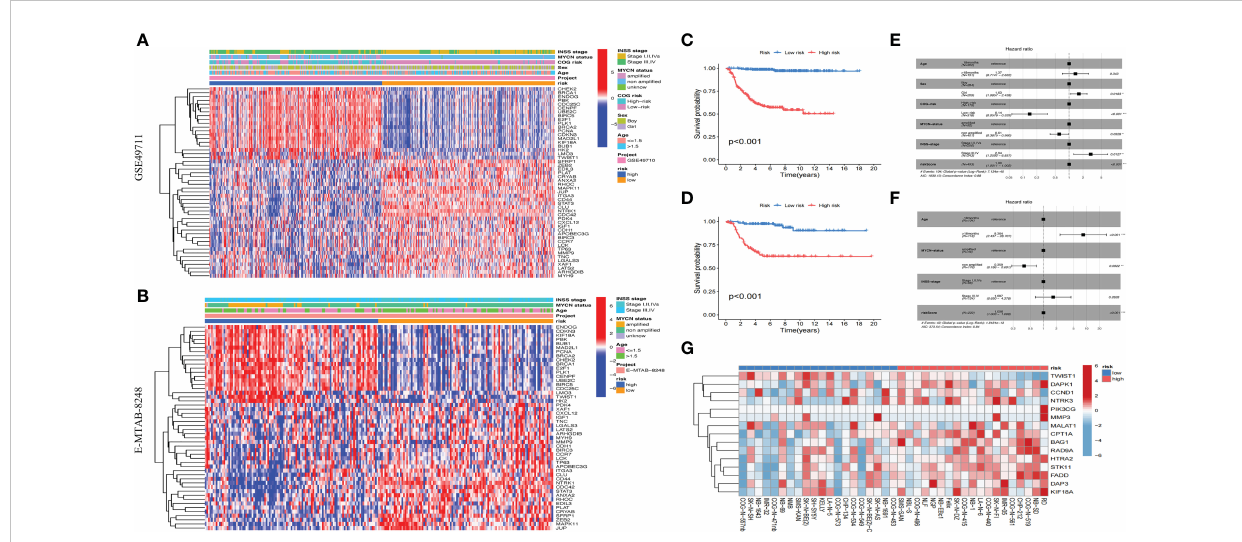
FIGURE 6 Validation of the anoikis-related model. (A, B) . Heatmap of clinical information and differentially expressed Args between two risk subgroups in GSE49710 and E-MTAB-8248. (C, D) : KM survival analysis of two risk subgroups in GSE49710 and E-MTAB-8248. (E, F) : Forest plots of multivariable cox regression analyses of the clinical features and riskscores calculated by the anoikis-related model in GSE49710 and E-MTAB-8248. (G) : Riskscores of 39 NB cell lines in GSE89413 cohort according to the constructed model. *, p < 0.05; **, p < 0.01; ***, p <